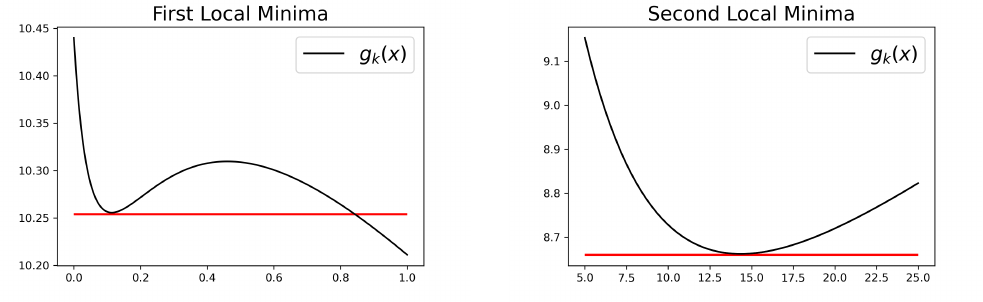
Figure 1. Two local minima: ( 0.11, 10.26 ) and ( 14.35, 8.66 ) obtained for g k ( x ) when α k ,1 = 1.2, α k ,2 = 3, d k ,1 = 10 and d k ,2 =